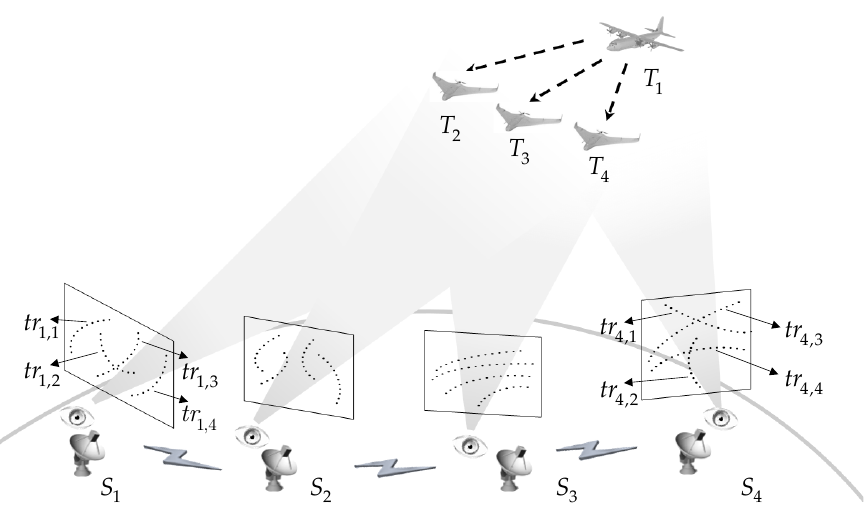
Figure 1. Illustration of multiple aerial targets in passive bearings-only sensor networks.